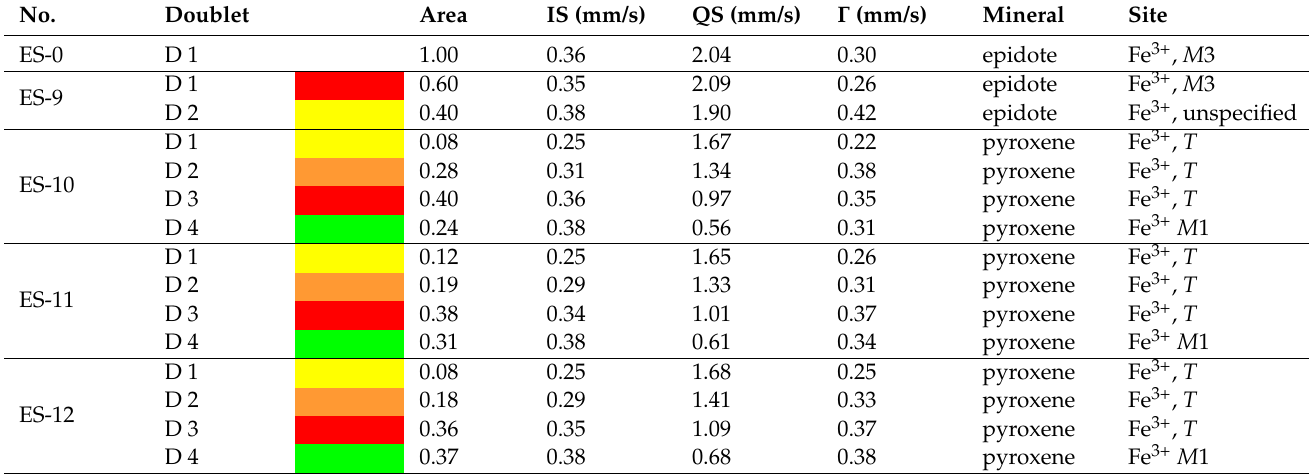
Table 9. Parameters of 57 Mössbauer spectra for epidote samples. Color of dublets is for their identification in the Figure